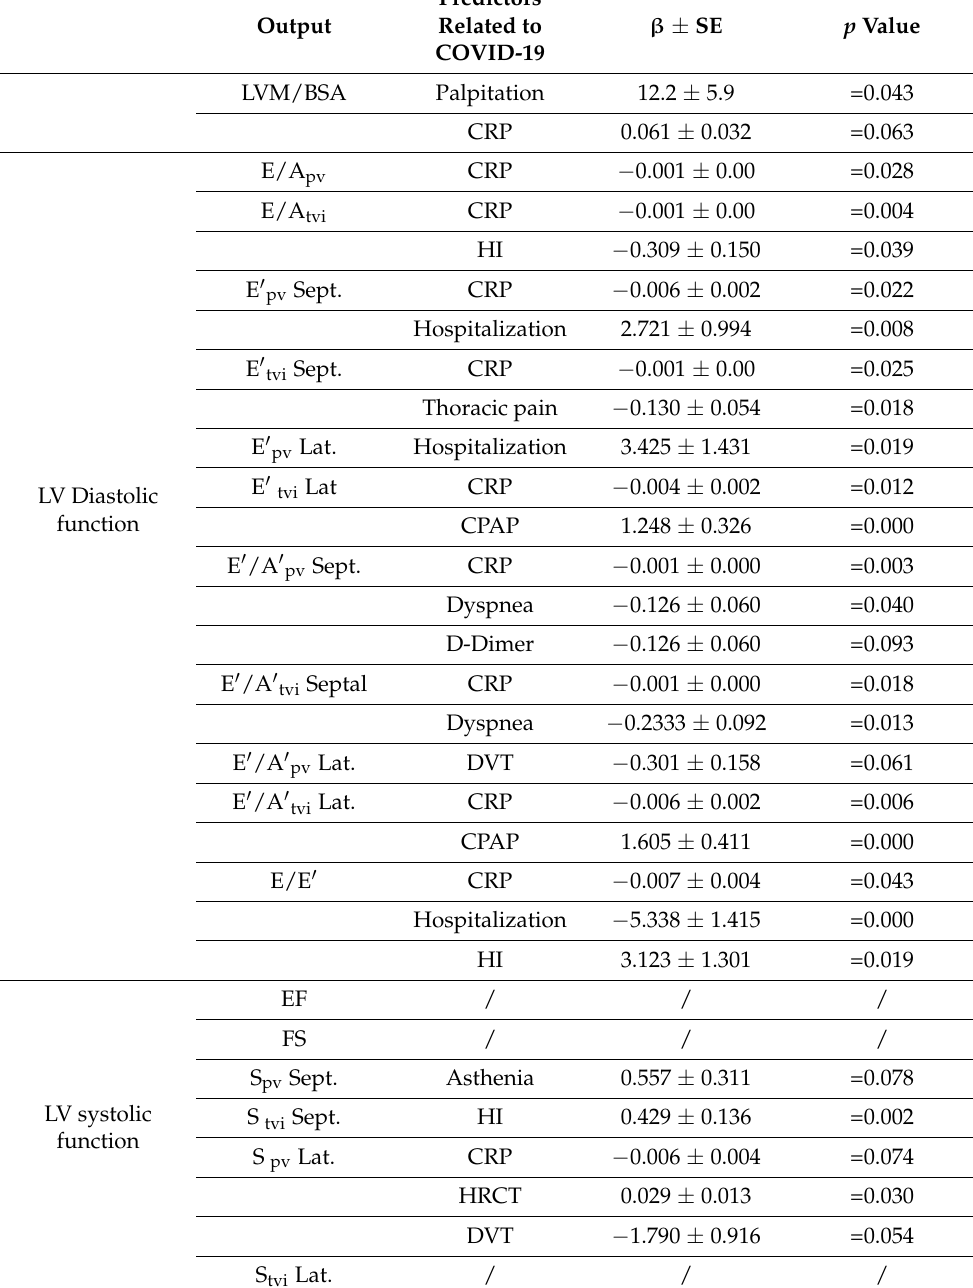
Table 5. COVID-19 alterations during the infection independently related to left ventricle at the follow-up: backward regression